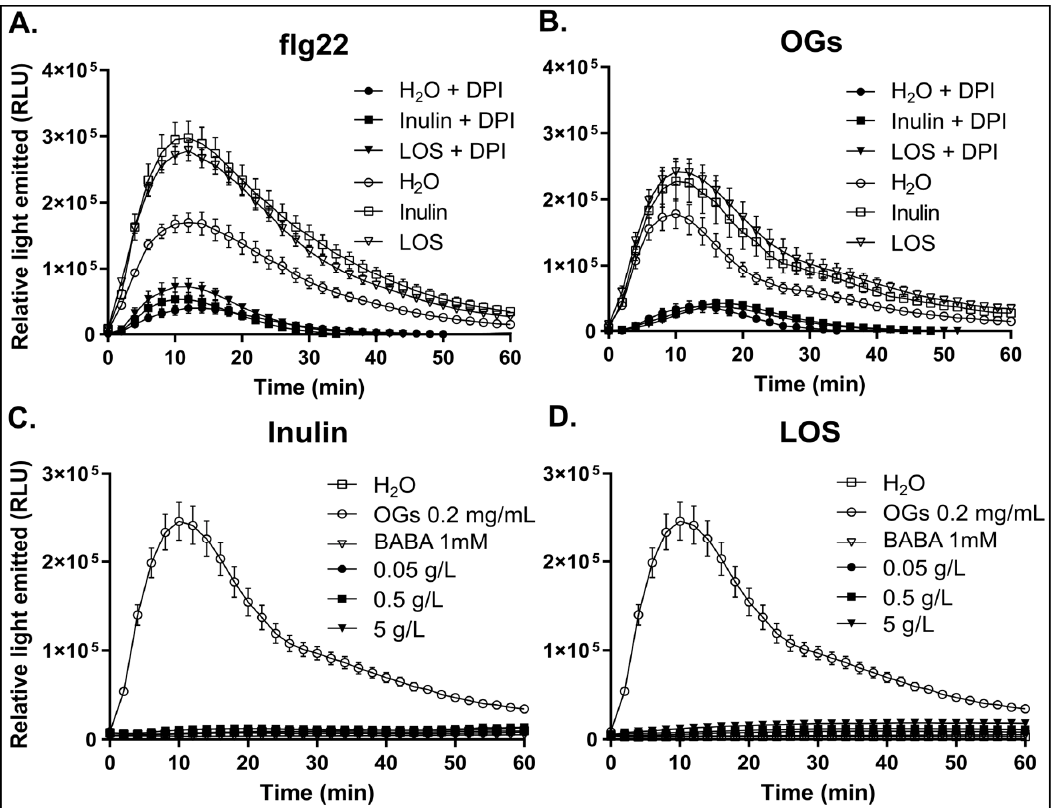
Figure 4. Priming of elicitor-induced NADPH-oxidase-mediated ROS production in plants pre-treated with inulin and LOS ( A , B ). ROS production in leaf disks in response to ( A ) 100 nM flg22 or ( B) 0.2 mg / mL OGs 24 h after pre-treatment with 5 g/L fructan. Diphenyleneiodonium (DPI) was added to 5 µ M final concentration for NADPH-oxidase inhibition. The graph represents the mean ± SE ( n ≥ 8). ( C , D ) Absence of a ROS burst in leaf disks in response to inulin and LOS treatment, as compared to BABA, OGs, and H 2 O control treatments with no elicitor. Arabidopsis leaf disks were treated with different concentrations of ( C ) inulin and ( D ) LOS and compared to OGs at 0.2 mg/mL and BABA at 1mM. Values represent the mean ± SE ( n = 16) and expressed as relative light units (RLU).